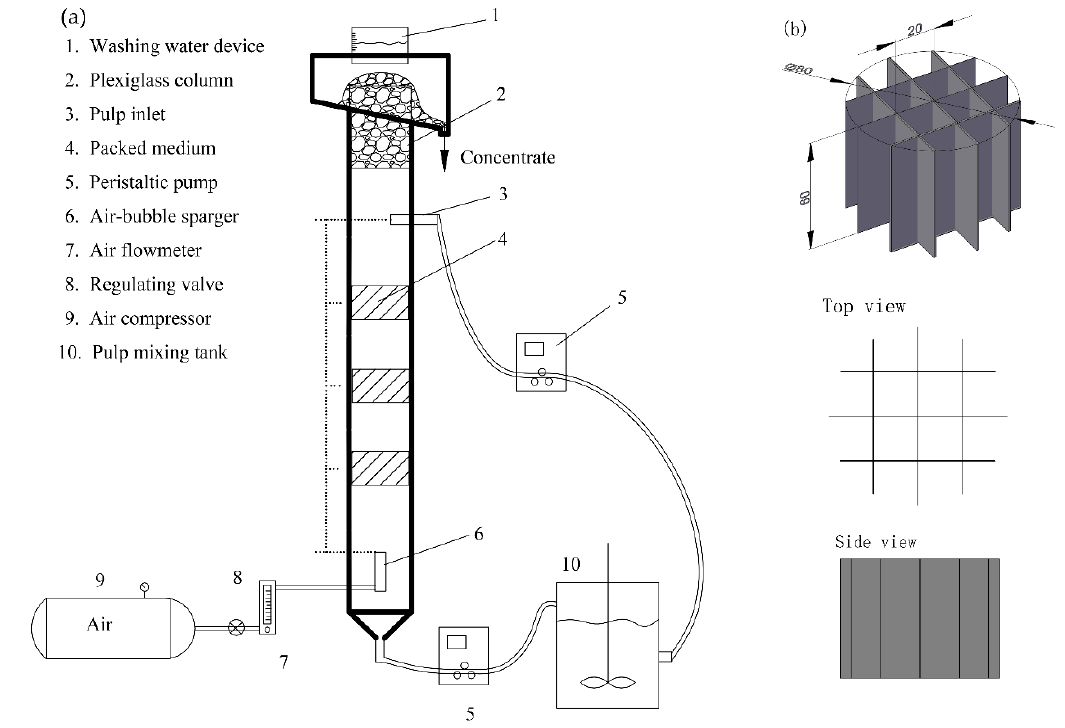
Figure 2. Experiment apparatus used for bauxite flotation: ( a ) flotation column system; ( b ) packing